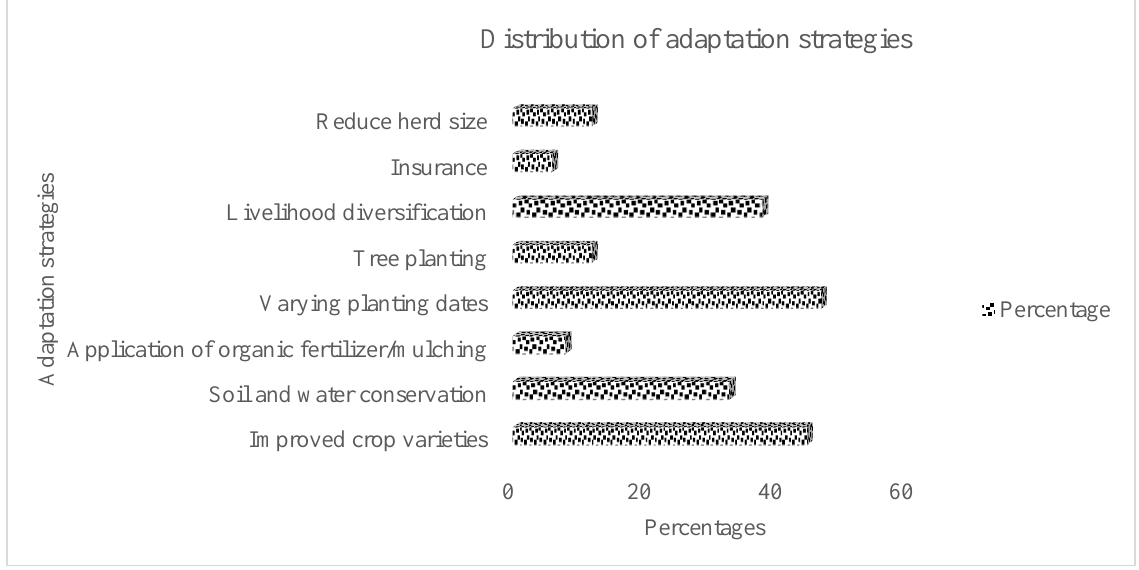
Figure 3. Distribution of adaptation strategies used by farmers in the study area.